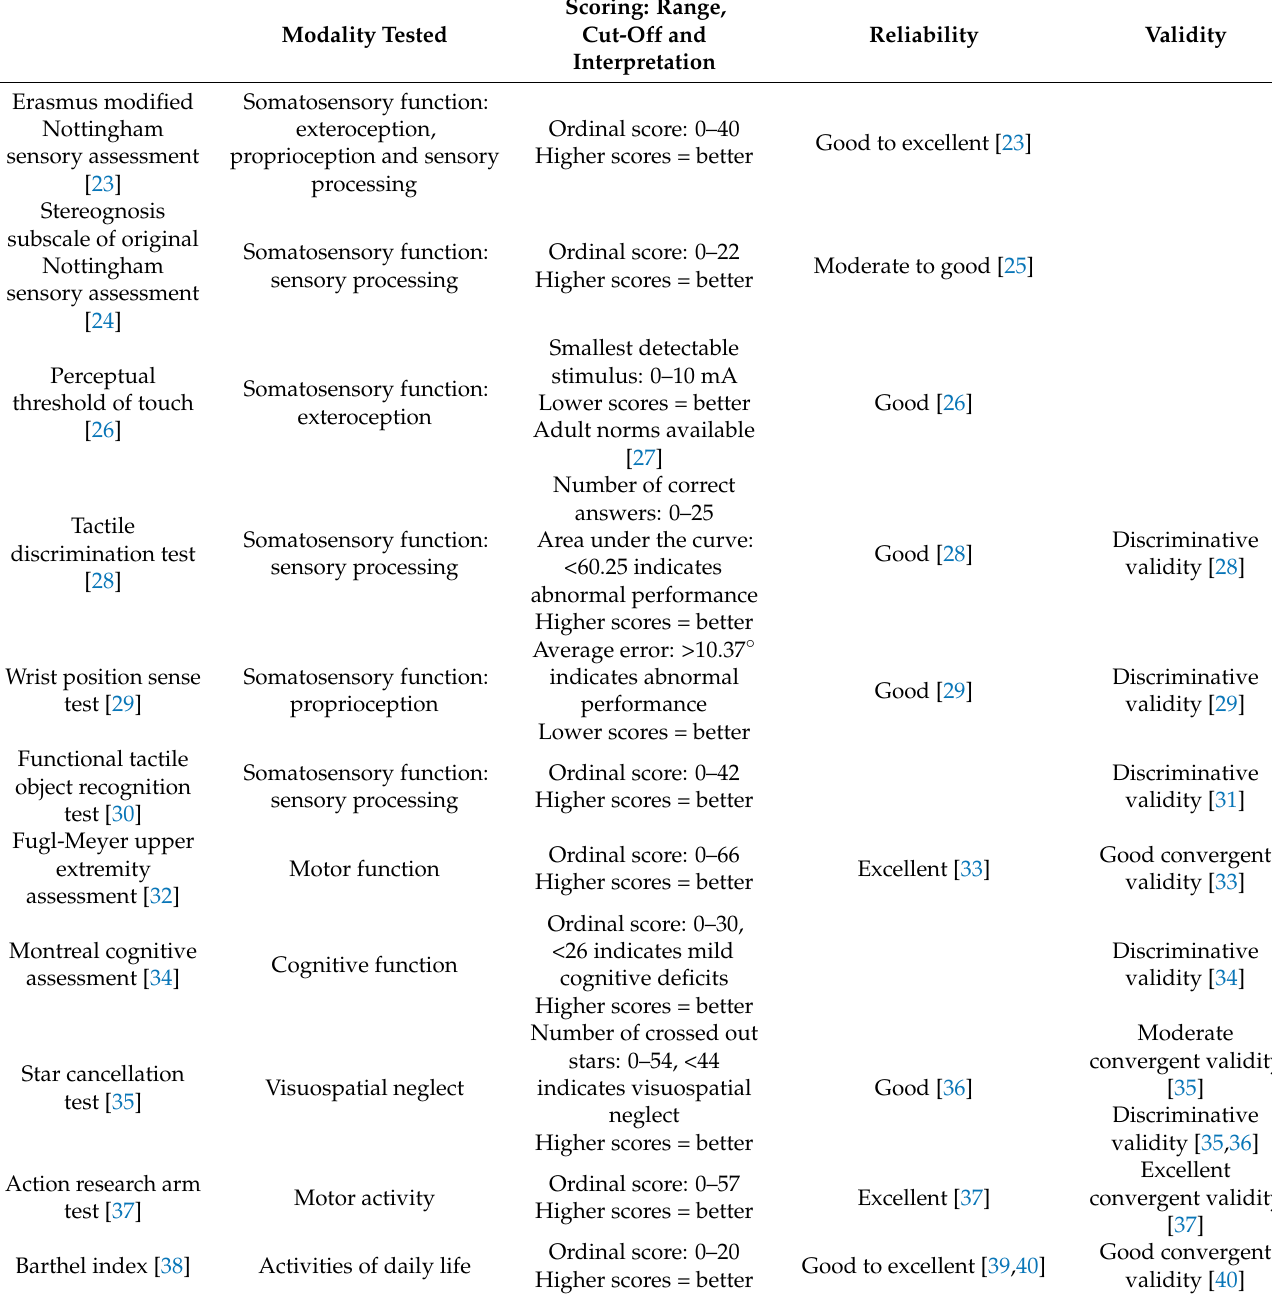
Table 2. Overview of clinical